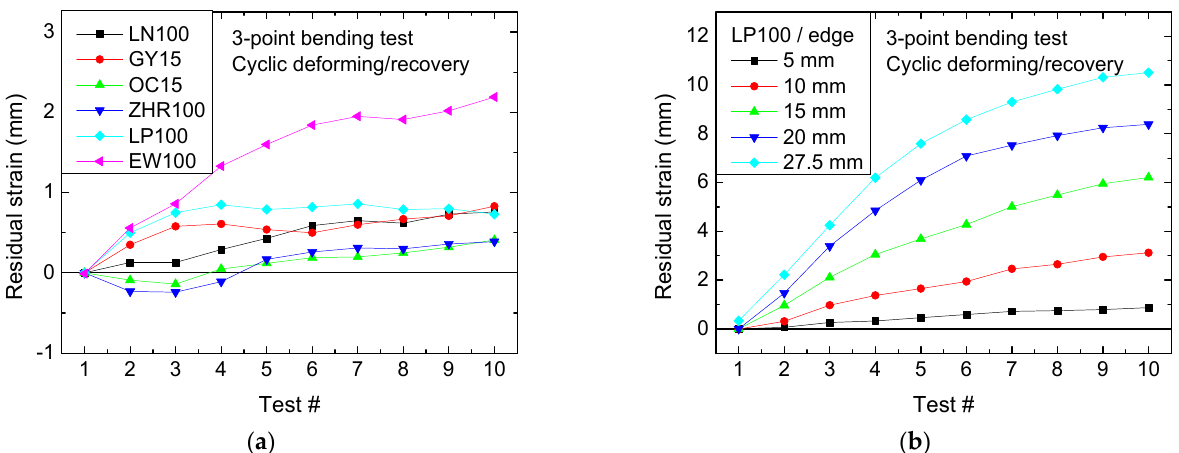
Figure 7. Residual strain of ( a ) samples printed flat; ( b ) sample LP100, printed on the edge, tested with different maximum deflections between 5 and 27.5 mm. Y -axis scales differ.